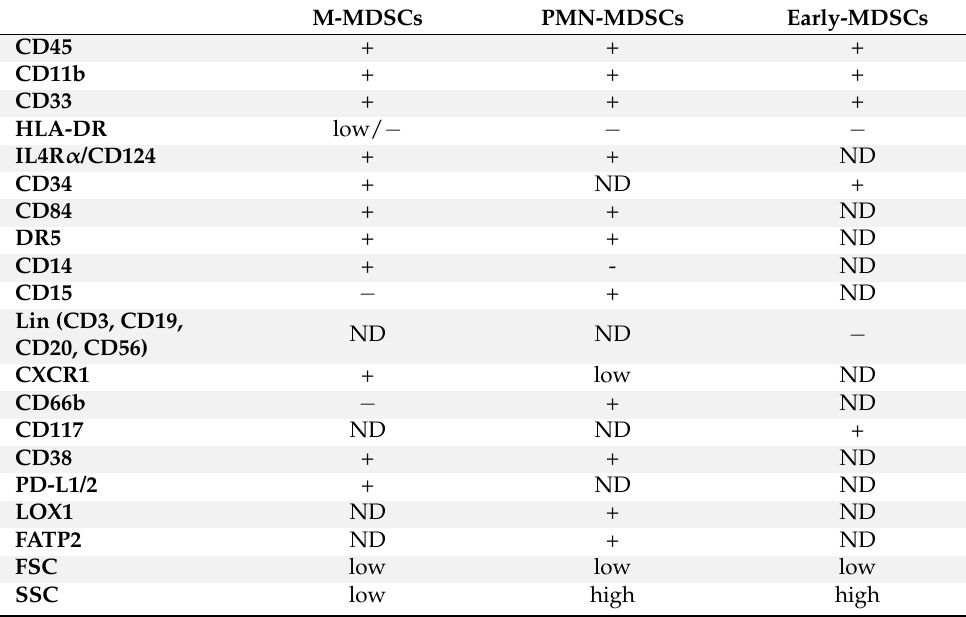
Table 1. Phenotype of human MDSC